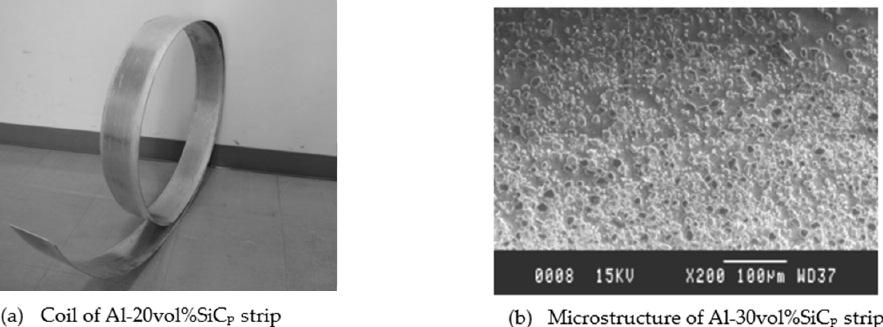
8 of 16 Figure 13. Effect of Fe content on full bending of strip cast by the VHSTRC. Cold-rolled and annealed 1-mm-thick strip was bent. Aluminum alloy: 6016 and Fe added 6016, Roll speed 60 m/min, Roll diameter: 300 mm, Roll width: 100 mm, Roll load: 0.14 kN/mm, Solidification length: 100 mm. Figure 14. Effects of Fe content on the results of a tension test. Cold-rolled and annealed 1-mm- thick strip was used for the tension test. The gage length was 50 mm. Aluminum alloy: 6016 and Fe added 6016, Roll speed 60 m/min, Roll diameter: 300 mm, Roll width: 100 mm, Roll load: 0.14 kN/mm, Solidification length: 100 mm. The VHSTRC can be used for strip casting of a particle-dispersed composite, such as